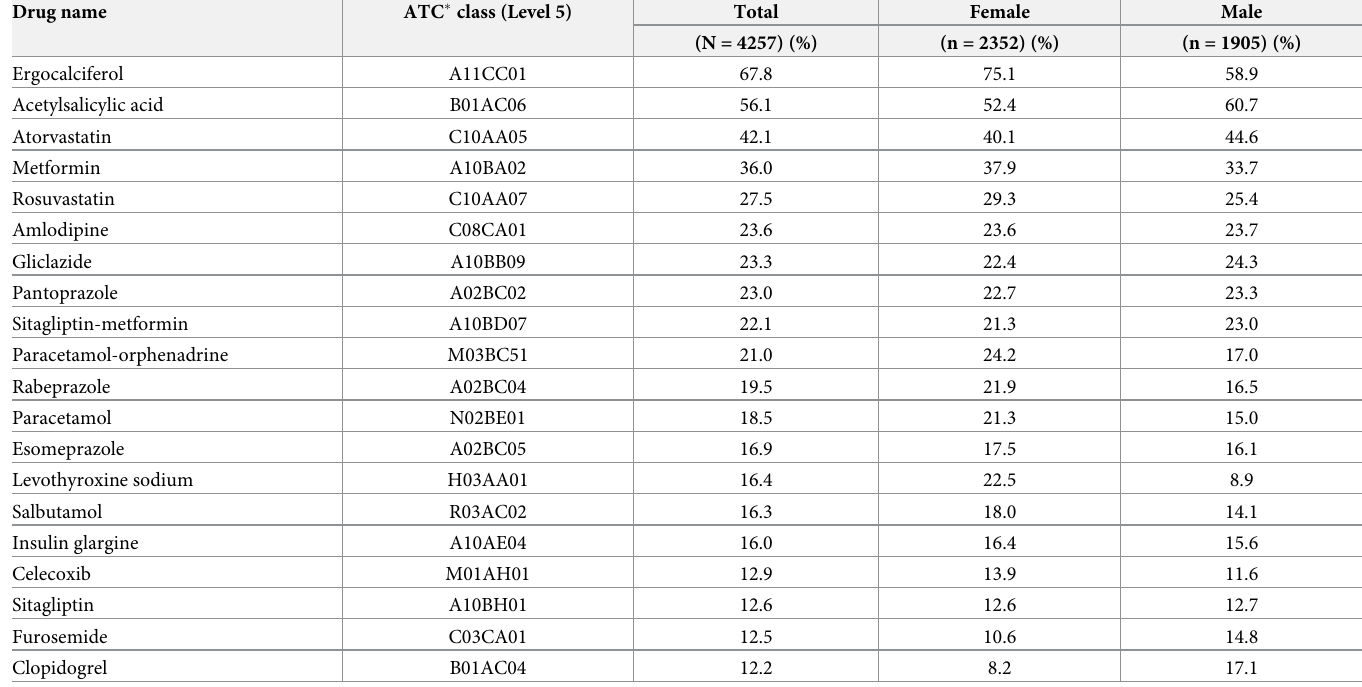
Table 3. Anatomical Therapeutic Chemical (ATC) Level 5 drug classes most frequently used by subjects exposed to polypharmacy and their distribution according to